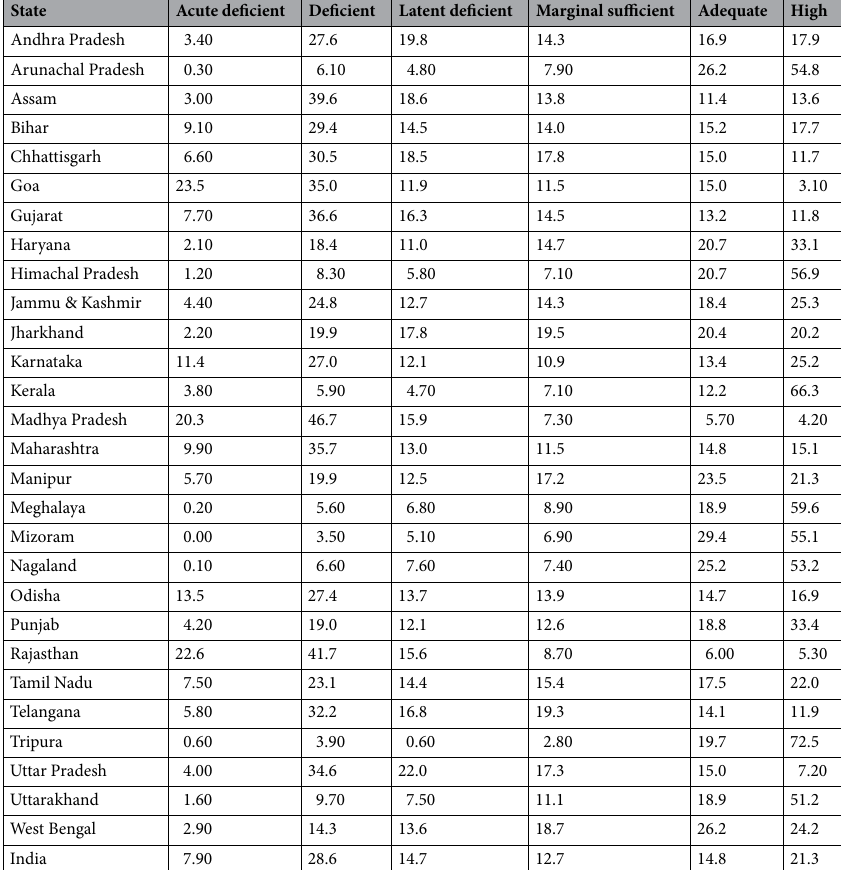
Table 3. State-wise deficiency (% of soil samples) status of available